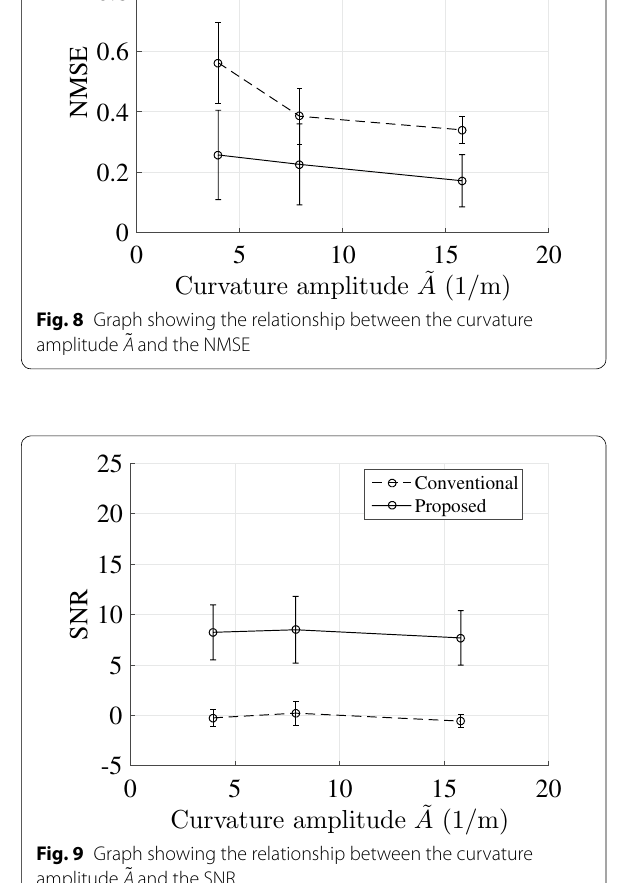
Figure 8 is an NMSE graph calculated for each cur- ˜ A vature amplitude . The horizontal axis represents the ˜ A curvature amplitude and the vertical axis represents the NMSE. Error bars show the standard deviation for 10 samples. In this figure, we can see that the estimated value using the proposed sensor is more accurate even if the curvature amplitude becomes larger. Furthermore, it